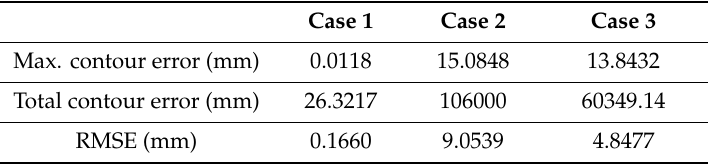
Figure 7. Simulation results, ( a ) performance of different case in X-Y-Z plane, ( b ) contour error of different cases, ( c ) performance of each axis, and ( d ) control effort. Table 1. Comparison results of adaptive model-free controller.